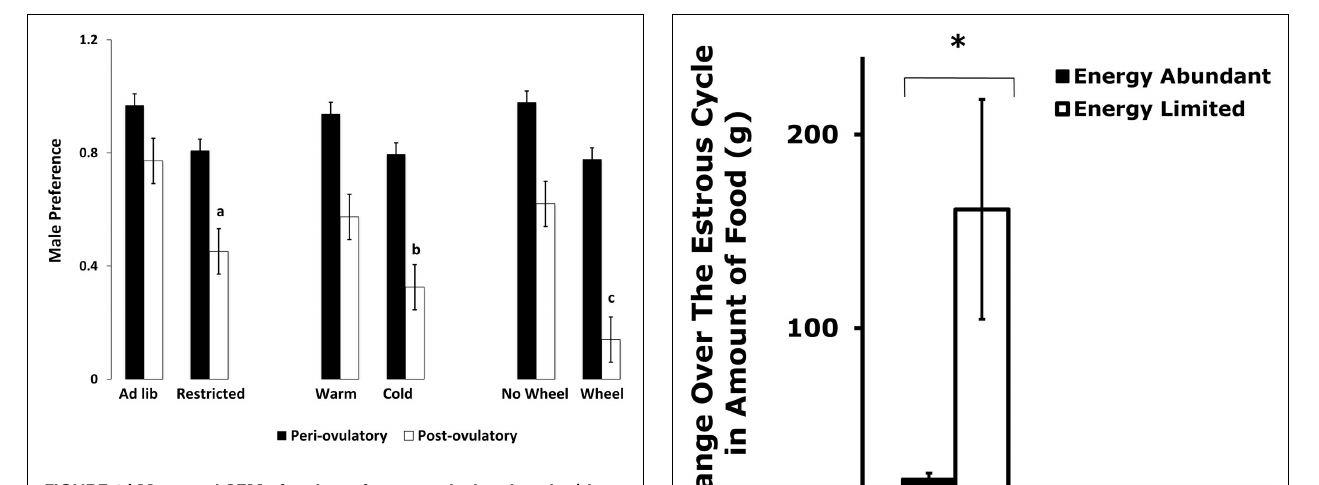
FIGURE 1 | Mean and SEM of male preference, calculated as the (time spent with the male minus the time spent with food) divided by the total time. Male preference is shown for females on either the periovulatory day (when circulating estradiol is high, black bars) or the postovulatory day when (circulating estradiol is low, white bars), in three experiments. Experiment 1 compared food-limited to food-unlimited females at 22˚C without access to wheels. Experiment 2 compared cold-housed (5˚C) to warm housed (22˚C) in females with unlimited food availability. Experiment 3 compared females housed with running wheels to those without running wheels at 22˚C with levels of food equal to those fed ad libitum without wheels. a = significantly different from ad libitum -fed at P < 0.01, b = significantly different from warm housed at P < 0.01, c = significantly different from no-wheel group at P < 0.001. Food-limited and unlimited groups adapted from Klingerman et al. (2010).